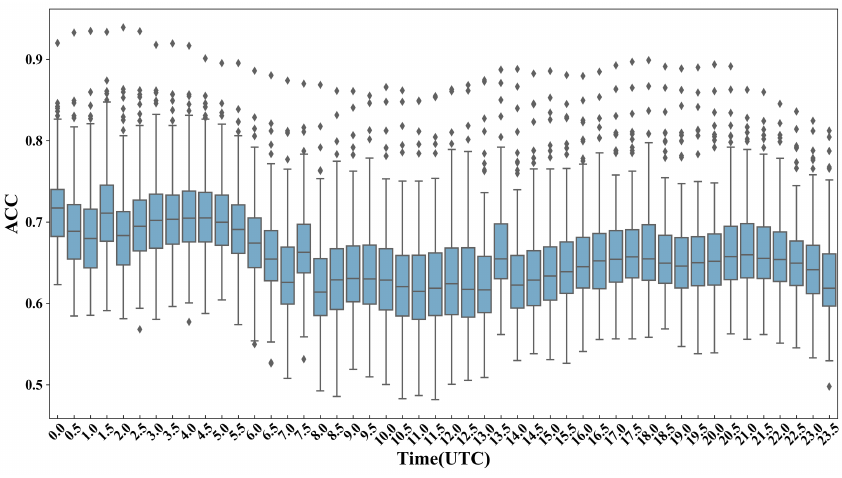
Figure 17. The diurnal variation of the accuracy for rainfall retrieval in the testing dataset in summer 2019; the distributions of the statistical values by half-an-hour are interpreted in box plots. Box diagrams indicate the 25th, 50th, and 75th percentiles, whereas the periphery of the box extends to 1.5-times the quartile deviation (25th–75th percentile). Outliers are indicated by black